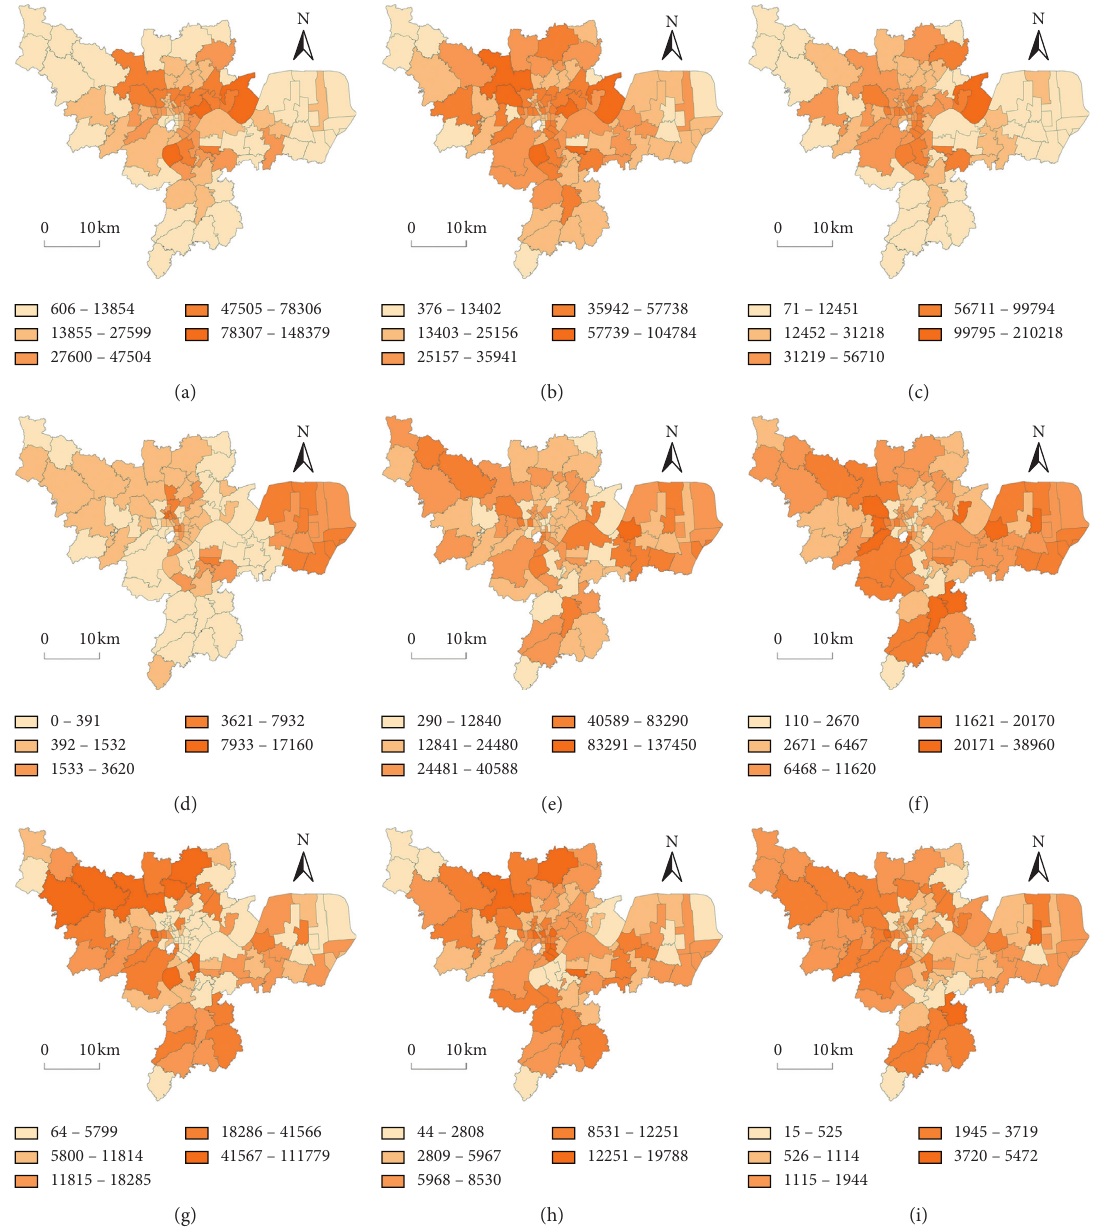
Figure 3: The distribution of different group in Hangzhou based on census data. (a) Migrant. (b) Female. (c) Hukou. (d) Agriculture and husbandry. (e) Professional and technical. (f) Business and services. (g) Highly educated. (h) Elderly. (i)